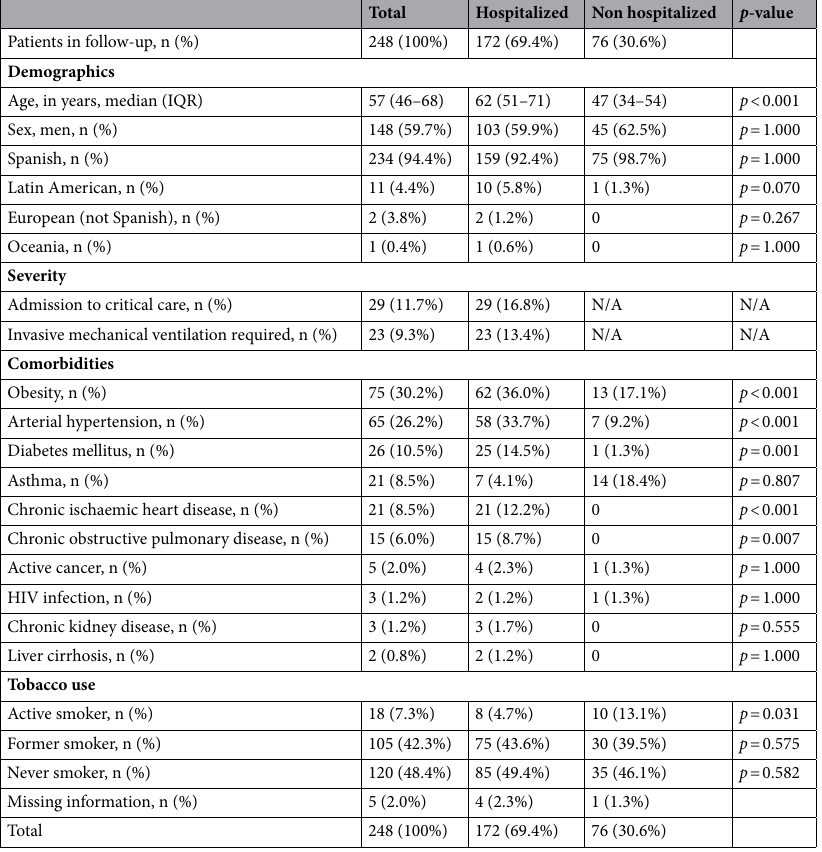
Table 1. Baseline characteristics of study